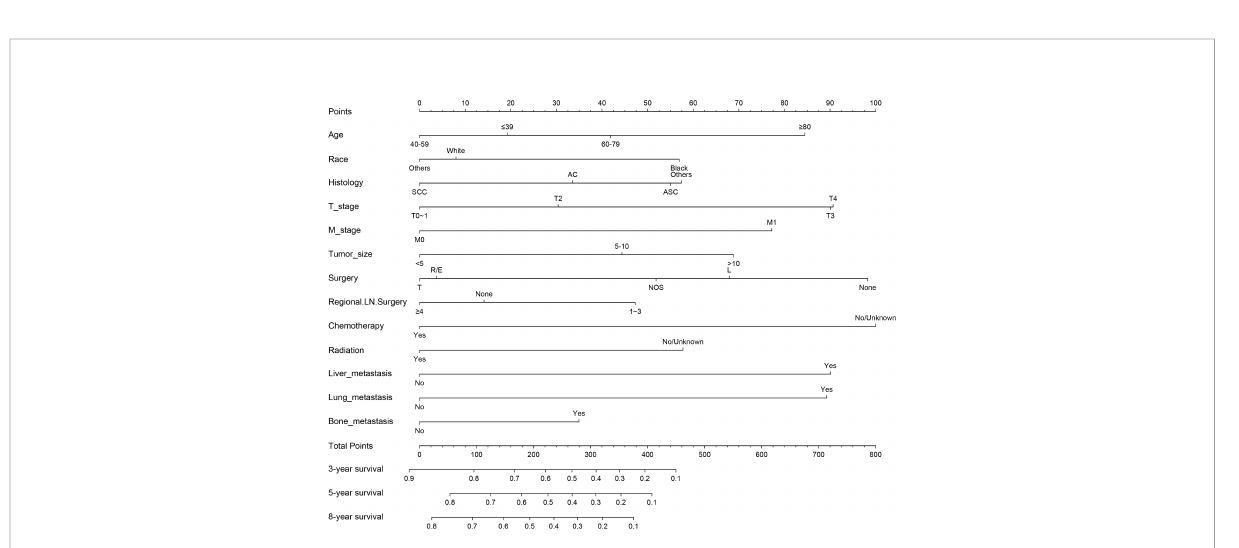
FIGURE 6 Nomogram for prognosis (overall survival) of patients with CC with LNM (Model 2). SCC, Squamous cell carcinoma; AC, Adenocarcinoma; ASC, Adenoskvamous carcinoma. L, Local tumor destruction/excision; T, Total hysterectomy (simple, pan-); R/E, Radical/extended